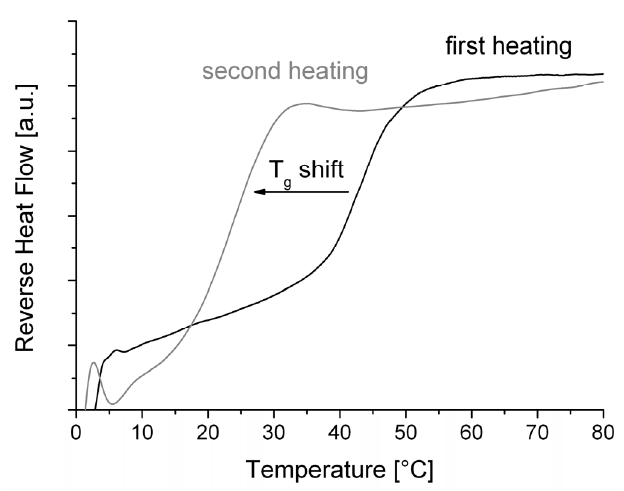
Figure 4. Shift of the glass transition temperature of P1 after the first heating